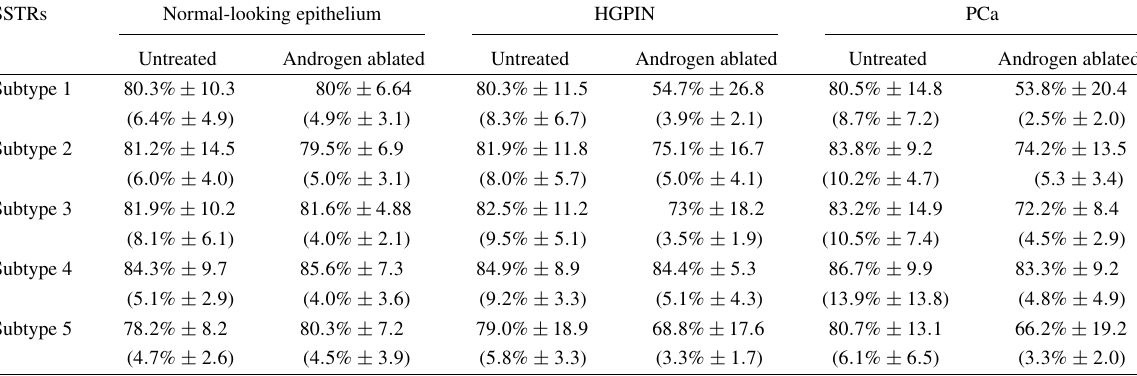
Percentages (mean ± standard deviation) of secretory cells with positive cytoplasmic staining